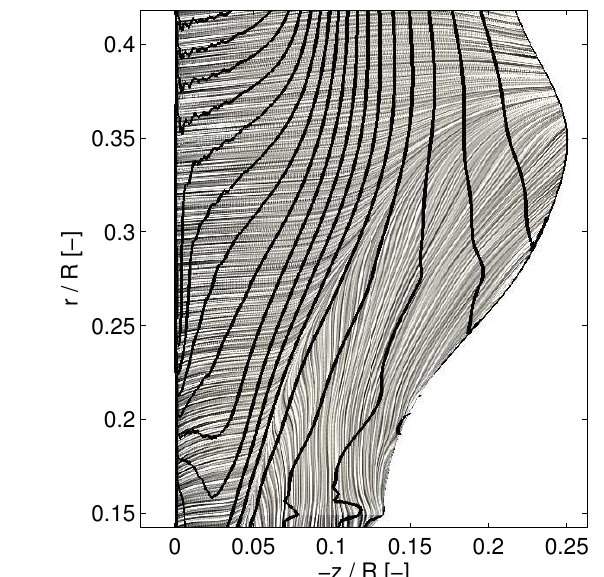
Figure 11. Isobars and limiting streamlines over the suction side of the blade root region (obtained from the numerical results).